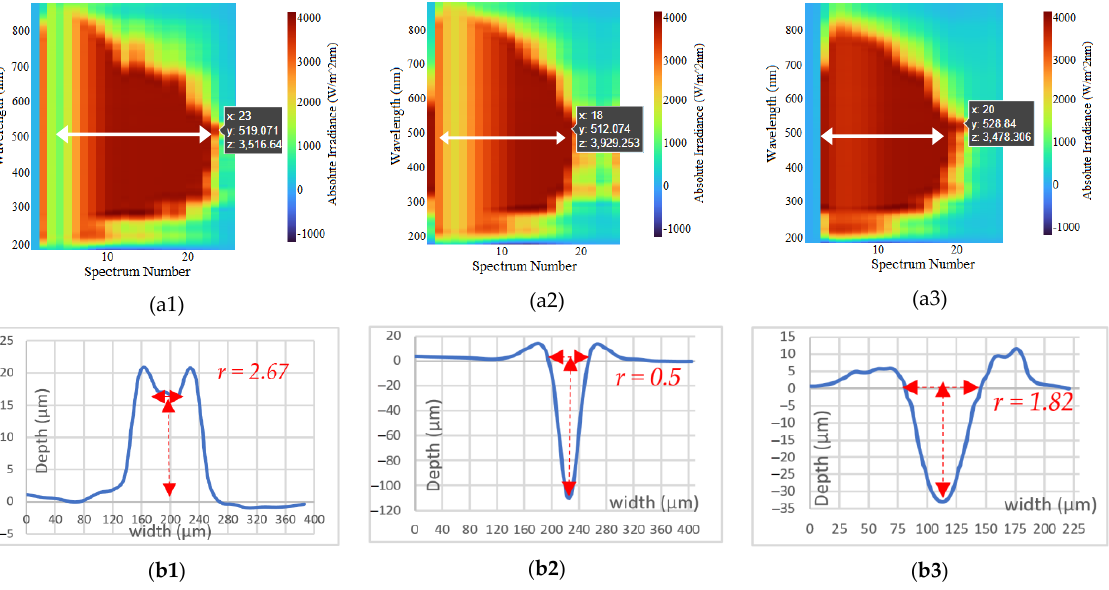
Figure 10. OES spectra of laser-copper interaction. ( a1 – a3 ): Heat-map of OES; ( b1 – b3 ): profilometer data from 3D microscope; 1: Maximum Power; 2: Medium Power; and 3: Minimum Power of laser. A larger r means that a higher intensity of optical emissions is recorded for a longer time and vice versa. For example, in Figure 9 the OES emission intensity at λ ≈ 500 nm remains longer in (a2), followed in longevity by (a1) and the shortest is (a3), which correlate well with the profilometer measurements. Figure 11 illustrates r vs. this longevity of OES for λ ≈ 500 nm. Therefore, OES can reveal information on the geometrical aspects of the ablated hole.